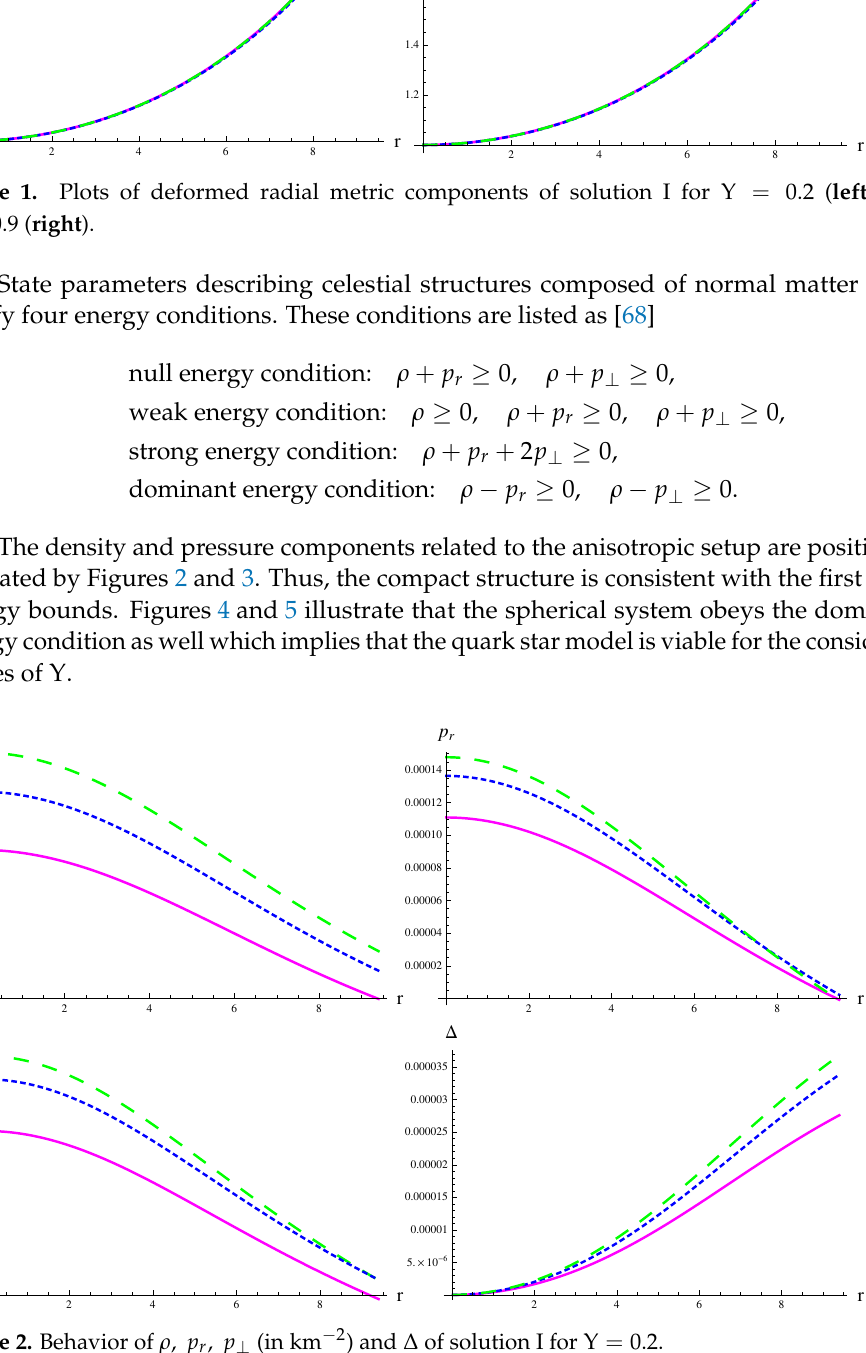
Figure 2. Behavior of ρ , p r , p ⊥ (in km − 2 ) and ∆ of solution I for Υ =